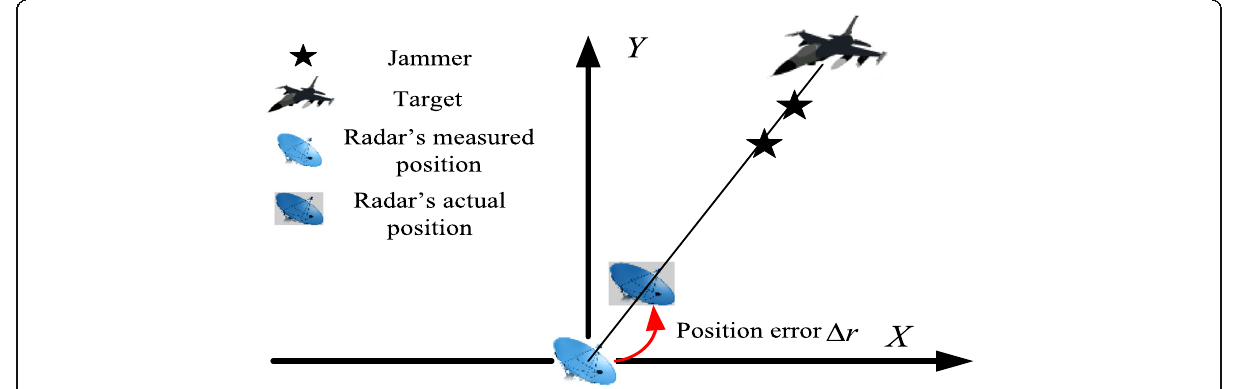
Fig. 3 Power-cooperative jamming generated by two jammers